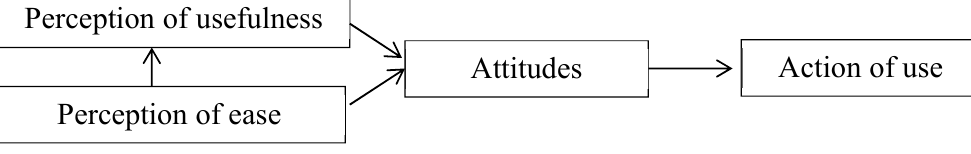
Fig. 1. Technology Acceptance Model (Davis,